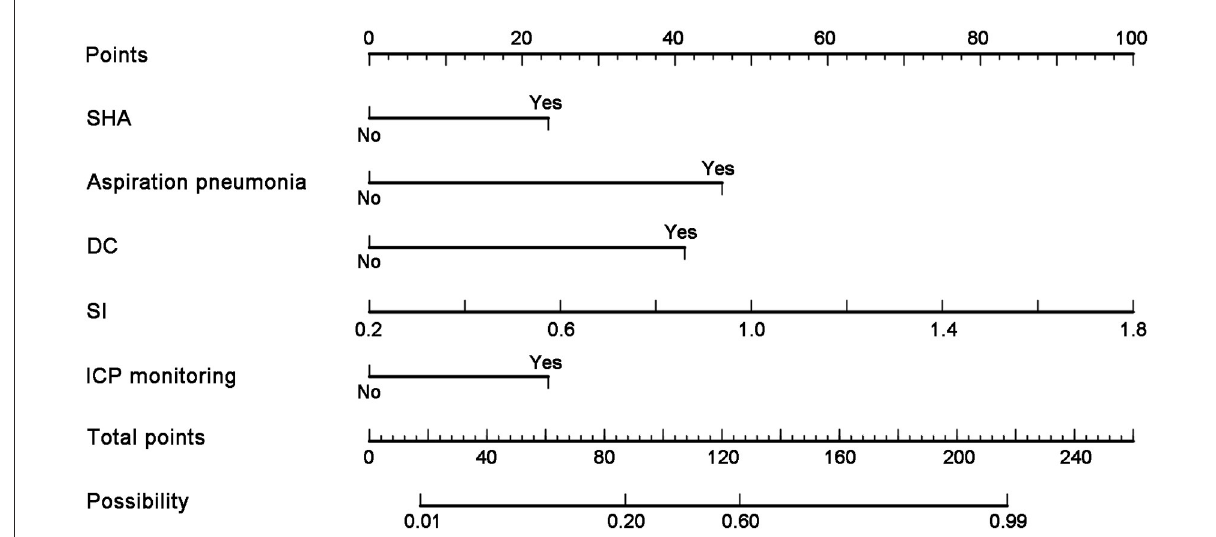
FIGURE4 Corresponding score for the nomogram model. A nomogram model for predicting the risk of complicated cerebral infarction in patients with brain herniation was established by R software. The combined SAH score was 21.5 points, the combined aspiration pneumonia score was 46.5 points, and the decompression without craniectomy score was 41.5 points, and without ICP monitoring score was 21.5 points. For every 0.2 increase in the SI value, the nomographic score increased by 11.1